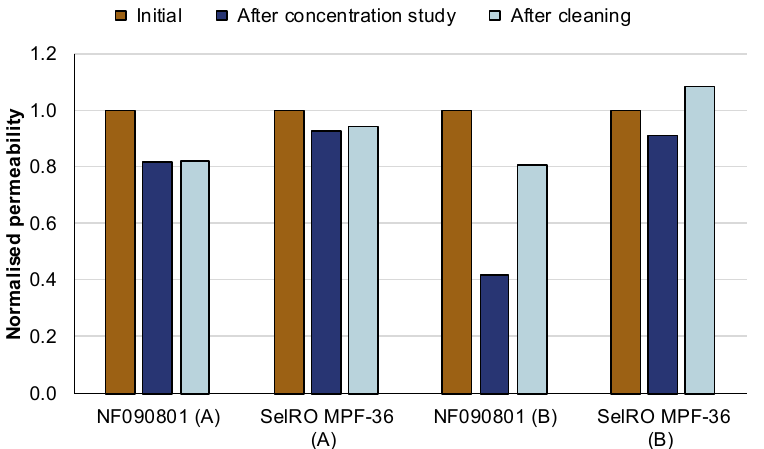
Figure 6. Normalized permeability before the concentration study (initial), after the concentration study and flushing with NaOH (after concentration study), and after cleaning with Ultrasil 110 (after cleaning) at condition A, 50 °C and 35 bar, and condition B, 70 °C and 15 bar.